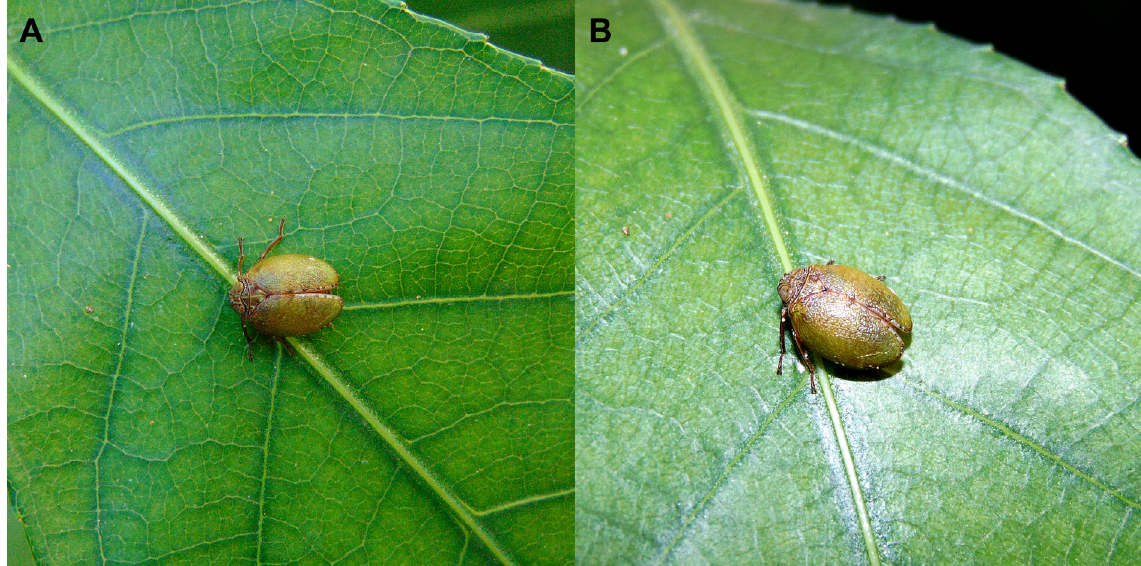
Fig. 7. Gergithoides ♀, unidentified species from Ba Vi National Park. A–B . Live specimen, 29 Jun. 2015 (photographs © J. Constant –